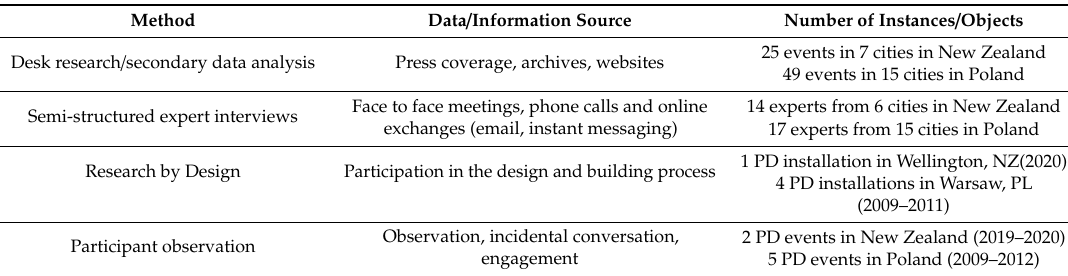
Table 1. Methods and data